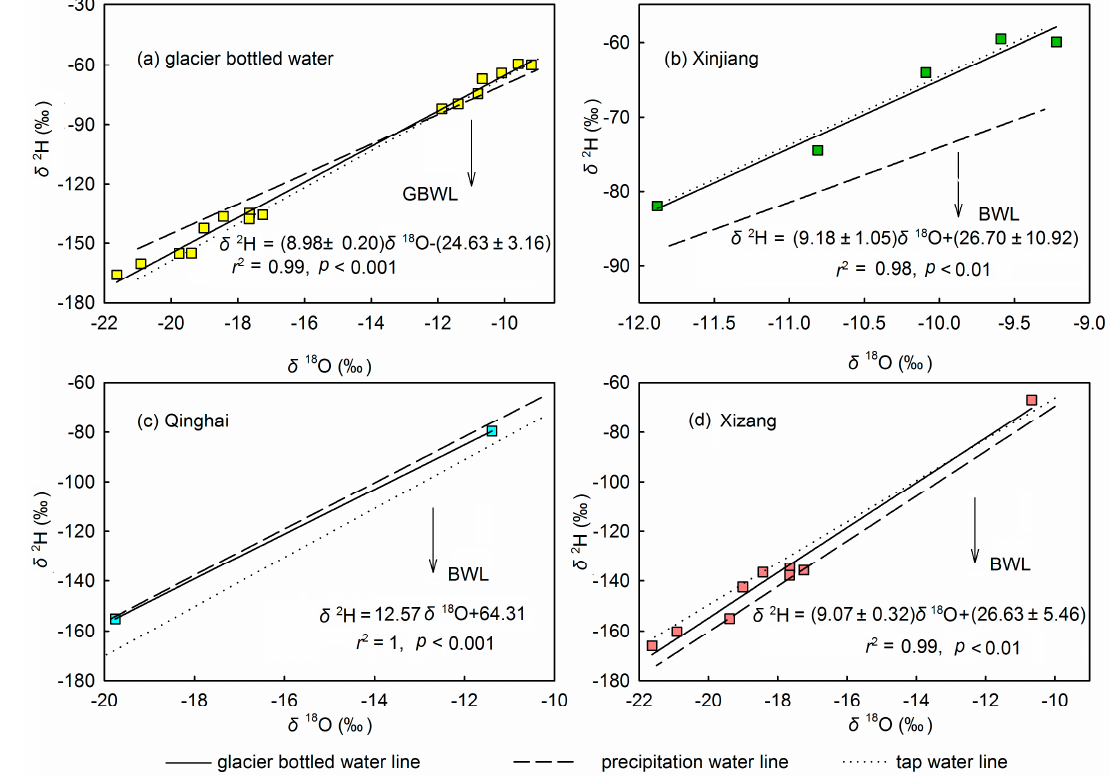
Figure 8. Hydrogen and oxygen isotope values of ( a ) all glacier-sourced bottled water, ( b ) glacier-sourced bottled water in Xinjiang, ( c ) glacier-sourced bottled water in Qinghai and ( d ) glacier-sourced bottled water in Xizang. The precipitation water lines in Xinjiang [44], Qinghai [45] and Xizang [29] are shown in Table S3. GBWL = glacier bottled water line.